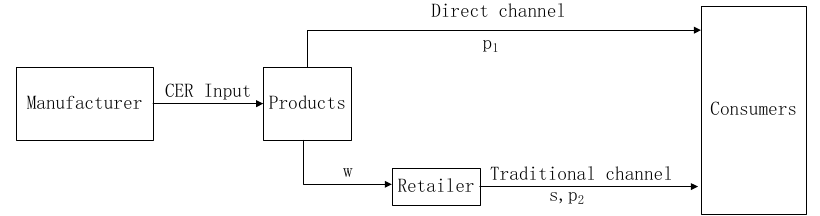
Figure 1. The low-carbon dual-channel supply chain system.